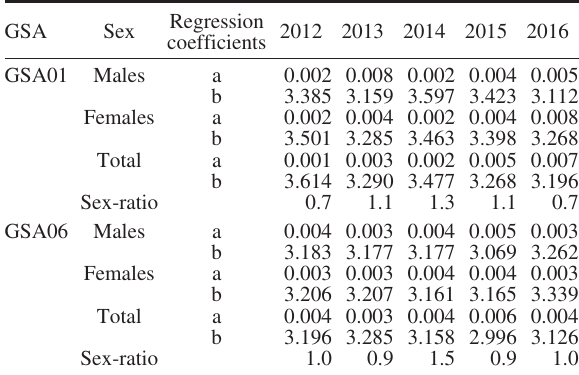
Table 3. – Time series values of the regression coefficients (“a” and “b”) of the length-weight relationships by GSA, year and sex, and the sex ratio (males/females) by year.